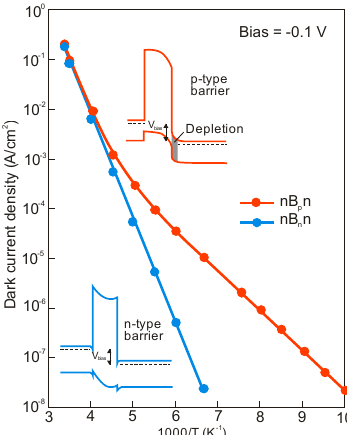
Figure 49. Dark current density vs. temperature for two identical InAsSb/AlSbAs nBn devices with opposite barrier doping. Active layer bandgap wavelength is 4.1 μ m at 150 K (after [150]).